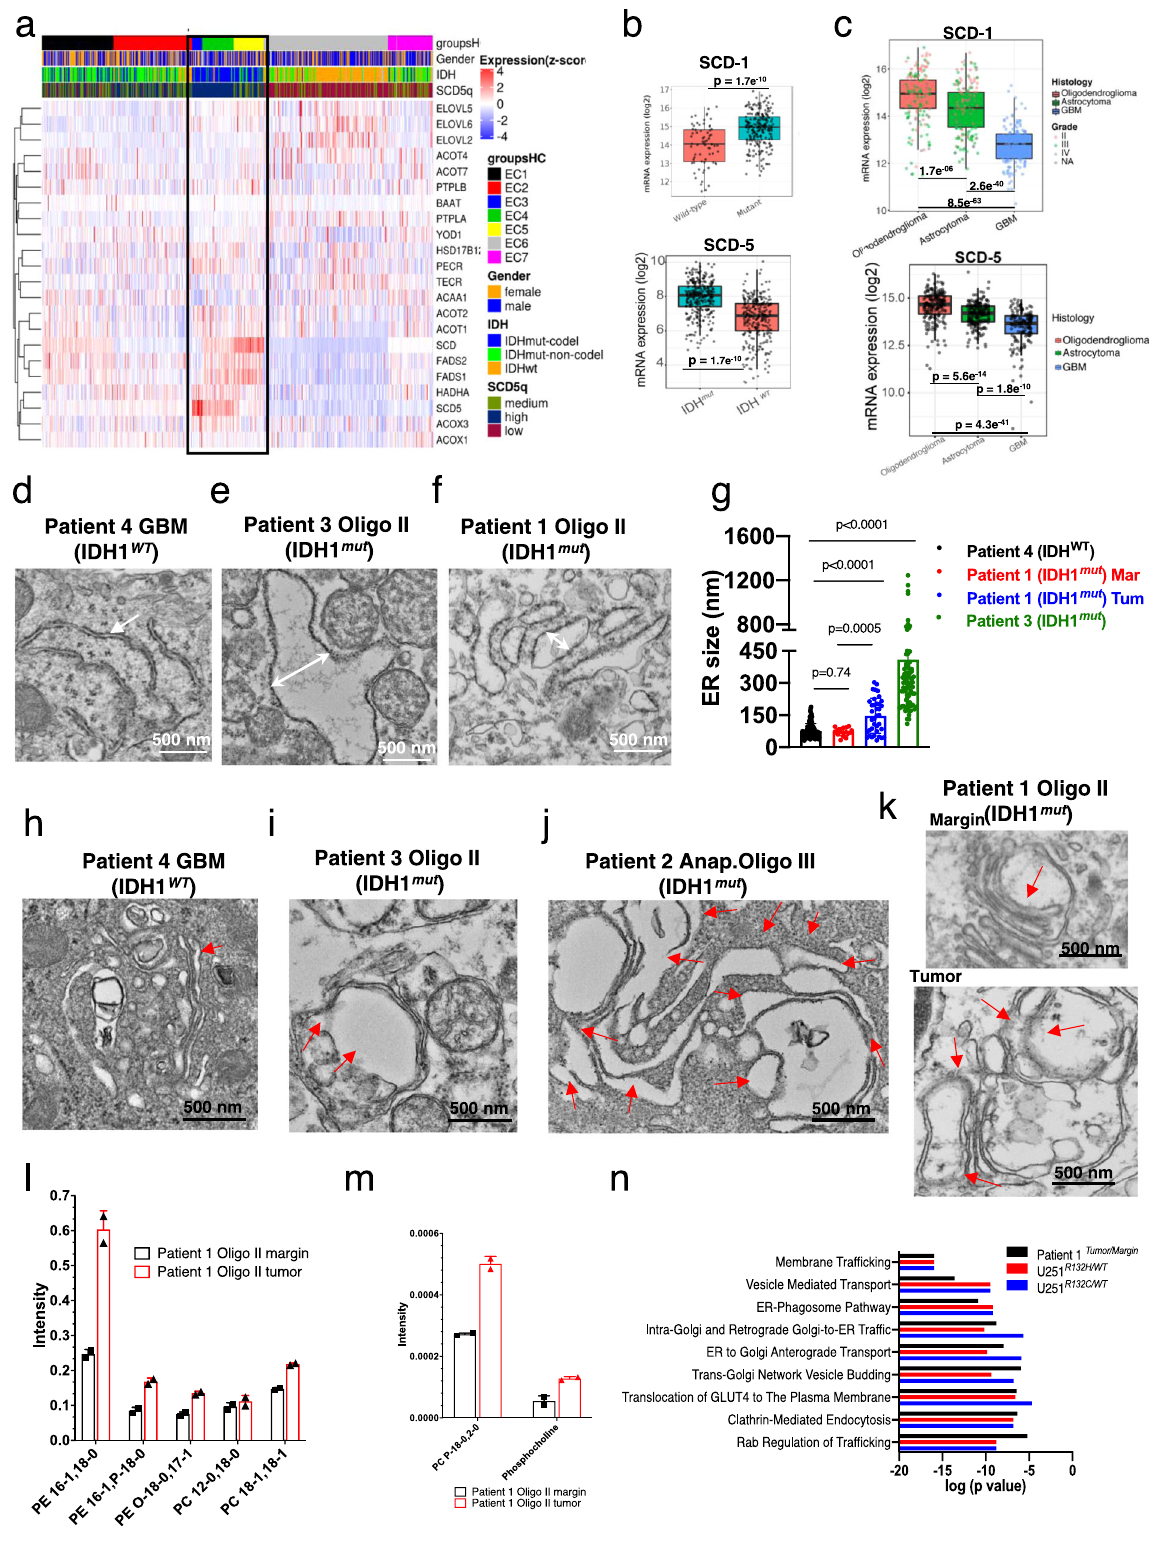
burden on ER and Golgi. Our hypothesis is con fi rmed by the proteomic analysis, which revealed membrane traf fi cking as a common upregulated pathway among cell lines and tissue with high signi fi cance. Although the link between altered lipidome and Golgi morphology via the membrane traf fi cking 41,42 has been